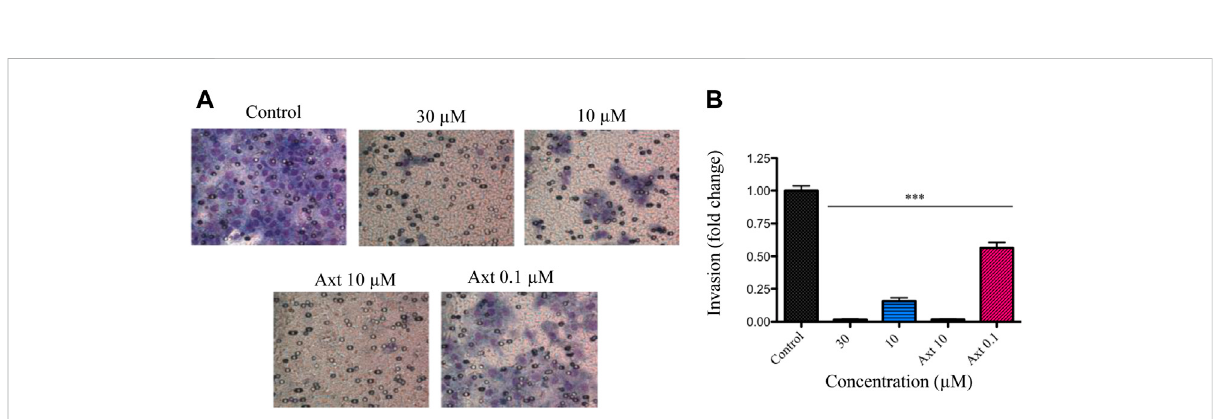
FIGURE 4 Effect of compound 3 on VEGF-induced invasion in BAECs.BAEC cells were treated with compound 3 (30 and 10 μ M) or axitinib (Axt, 10 and 0.1 μ M) and the Matrigel invasion assay was performed in a 24 h time frame. (A) The images display representative fi elds of invading cells. (B) Graphs show the percentage of invading cells per fi eld relativized to the control. Results are expressed as mean ± SEM. Statistical analysis was performed by ANOVA followed by Dunnett ’ s post-hoc test compared to negative control (*** p <